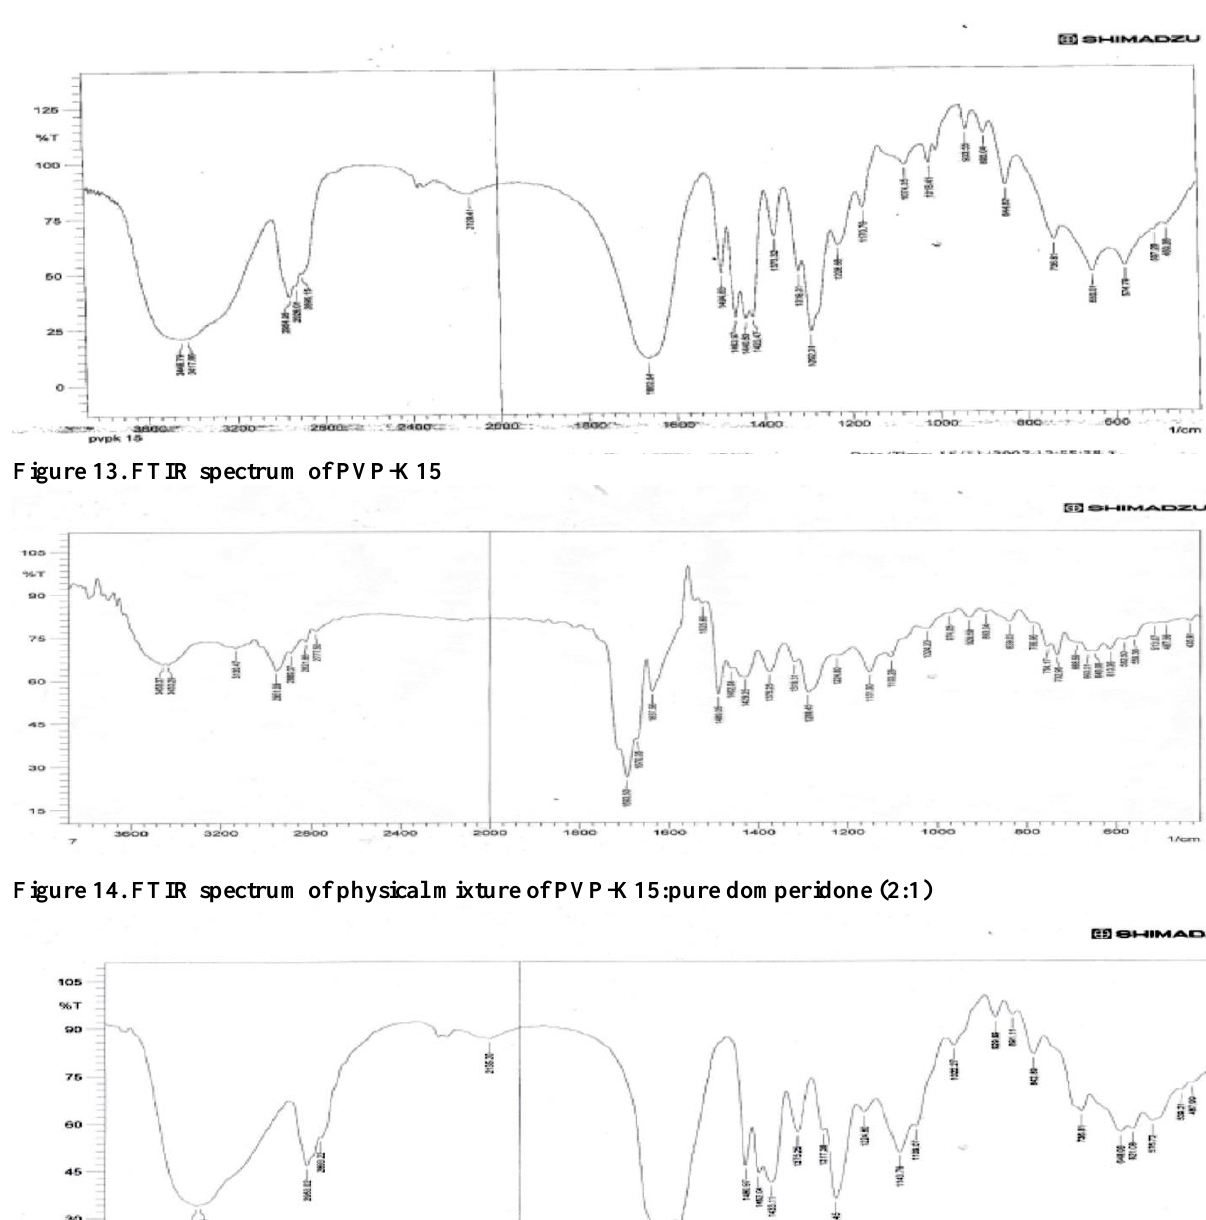
Figure 15 . FTIR spectrum of F8 Differential scanning calorimetry